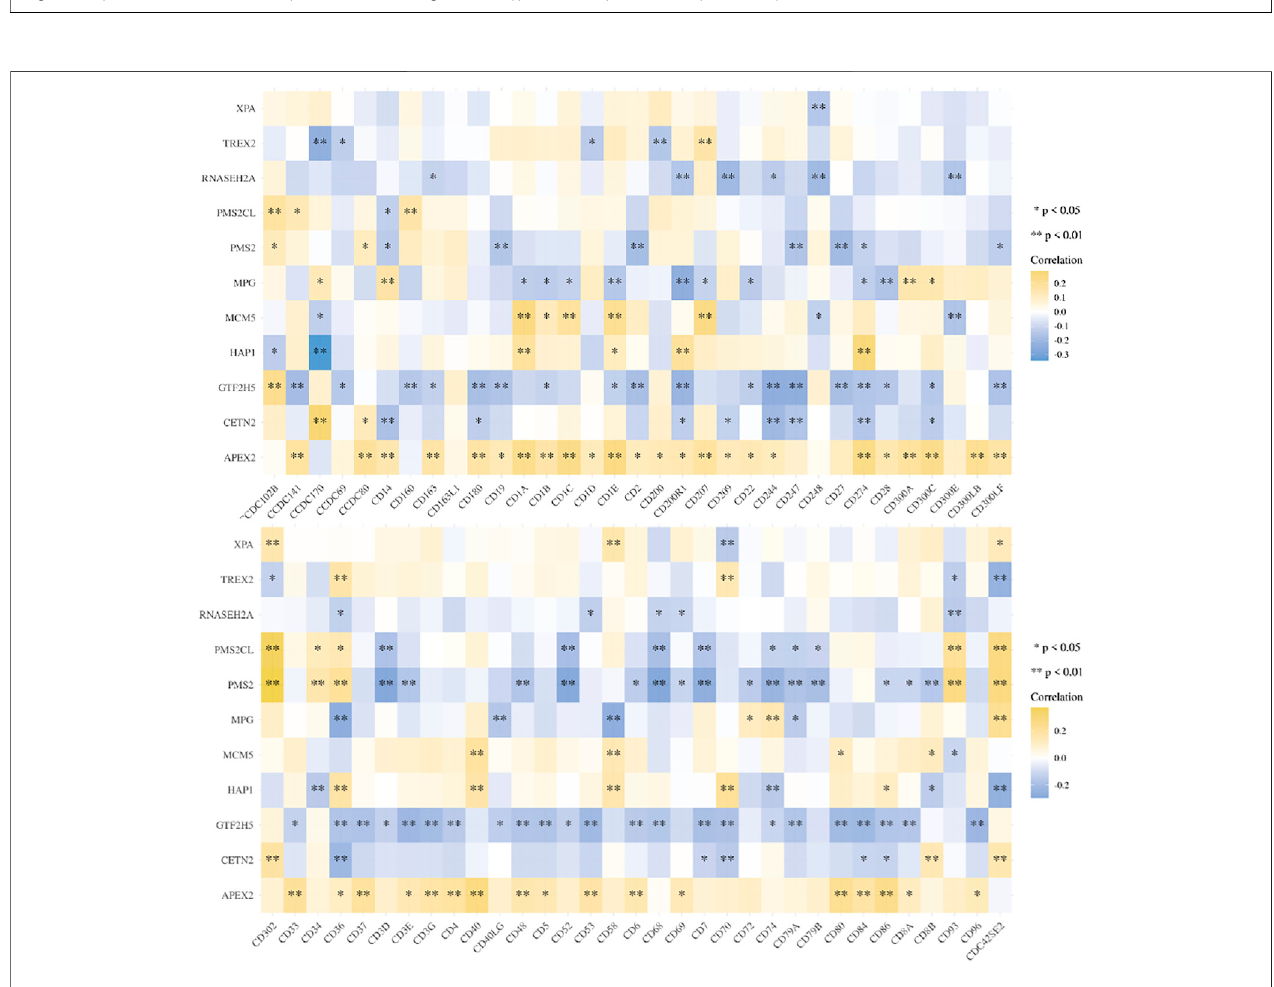
FIGURE 5 | Heatmap of key genes correlation with the CD family.